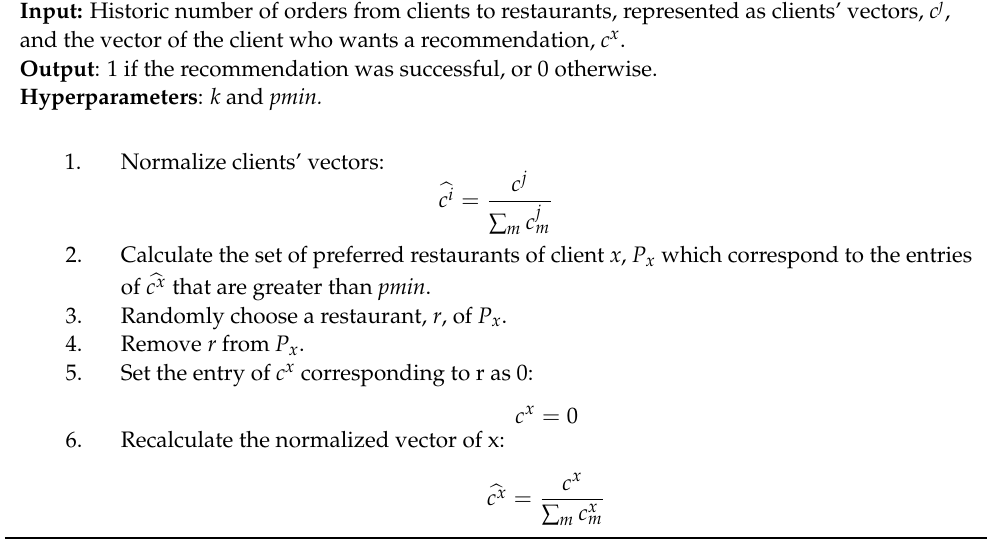
Algorithm 2. Pseudocode of the performance